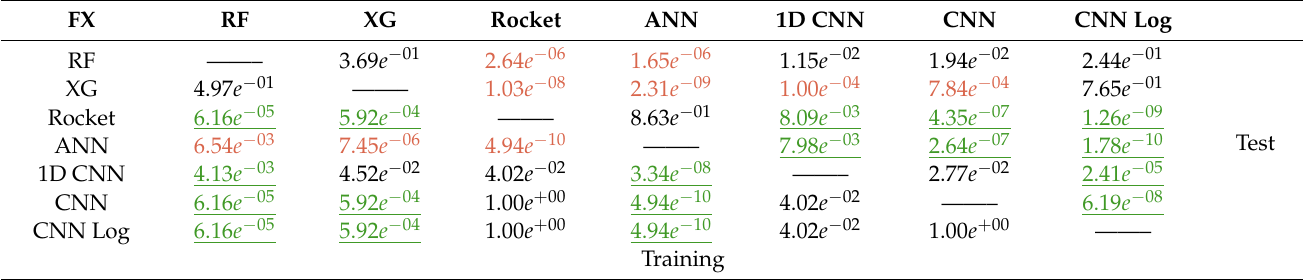
Table A3. Kruskal–Wallis p -values comparing all methods of the FX concentration prediction task. Above the diagonal, we have the results for the test set, and below for the training set. Significant results ( p < 0.01) are represented in green or red when the method on the left is significantly better or worse,